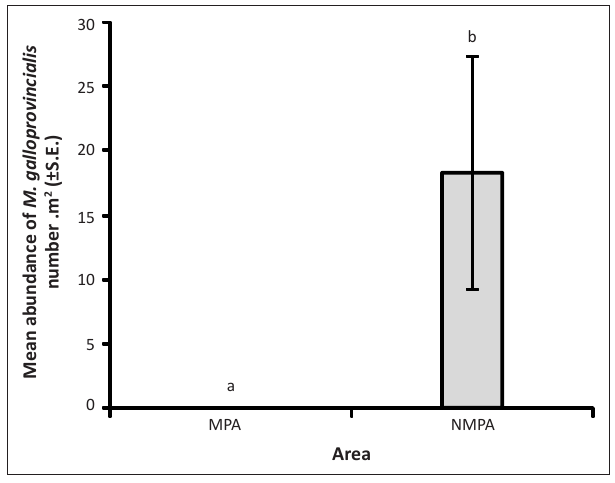
FIGURE 2: Abundance of Mytilus galloprovincialis in the marine protected area and non-marine protected area.